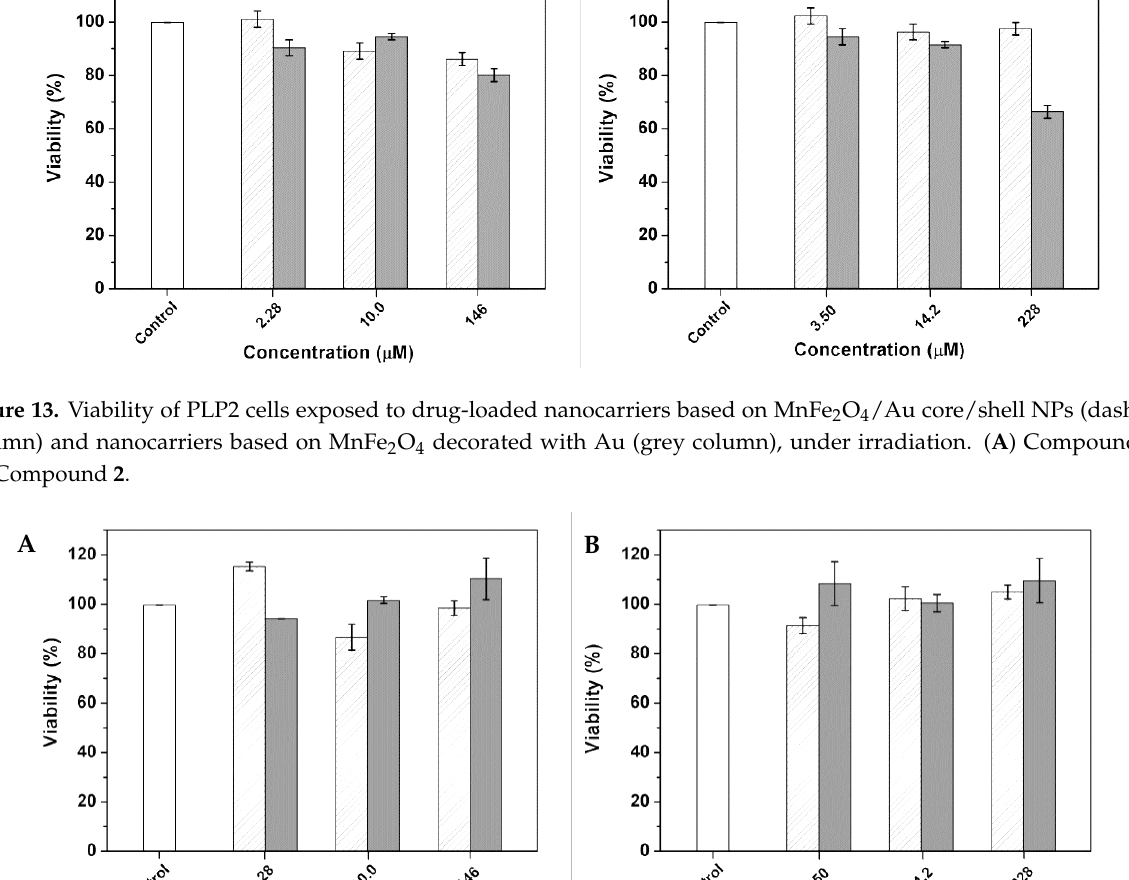
Figure 12. Fluorescence spectra of ( A ) compound 1 ( λ exc = 370 nm) and ( B ) compound 2 ( λ exc = 420 nm) in magnetoliposomes before and after interaction with GUVs.